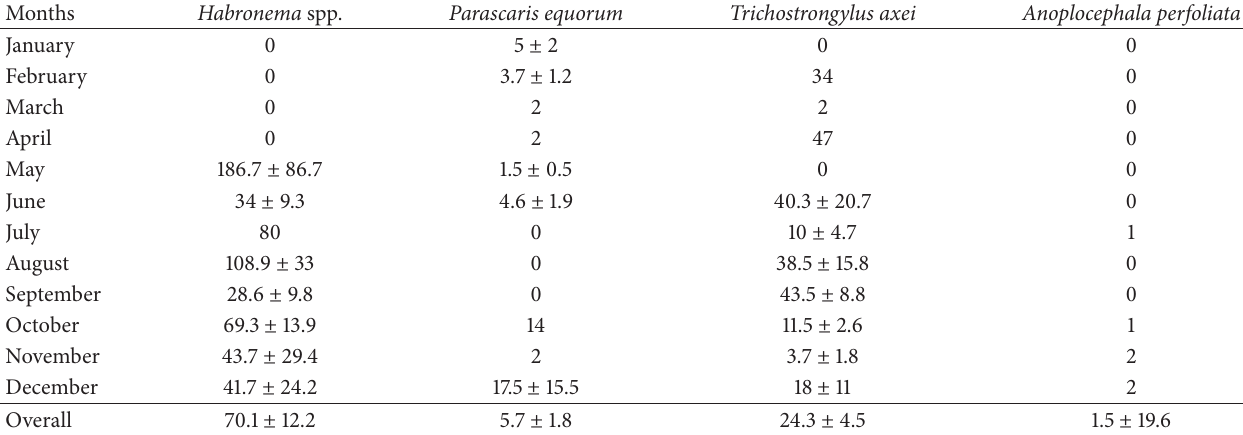
Table 3: Monthly mean count ± SEM of parasites recovered from stomach and small intestine of necropsied donkeys. Months Habronema spp.